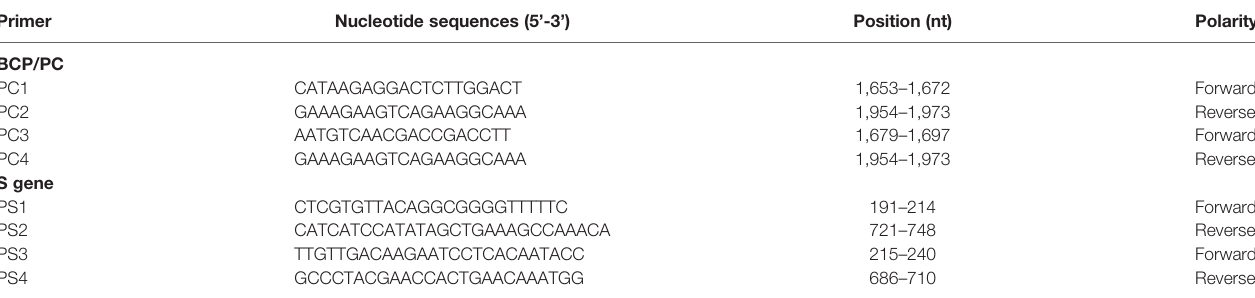
TABLE 1 | PCR primers for HBV DNA used in this